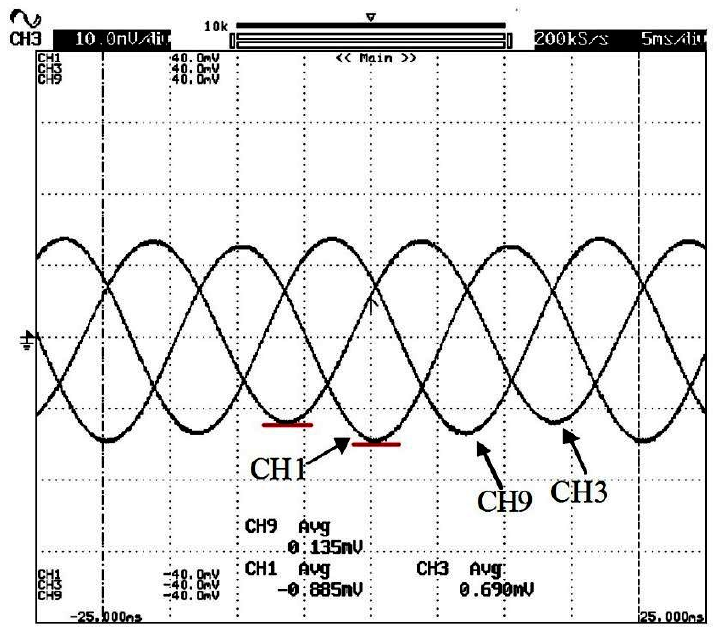
Figure 2. Currents in the three-phase ohmic-inductive load at 15 kHz switching frequency [9].